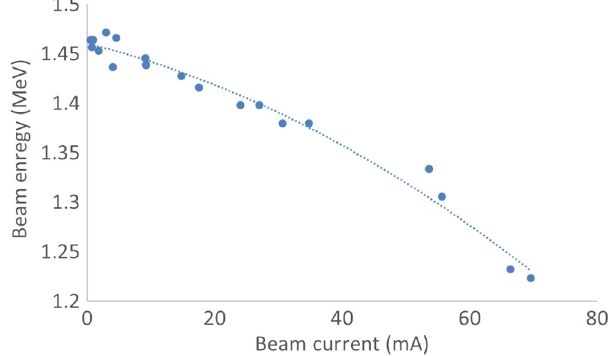
FIG. 21. Beam energy as a function of beam current.